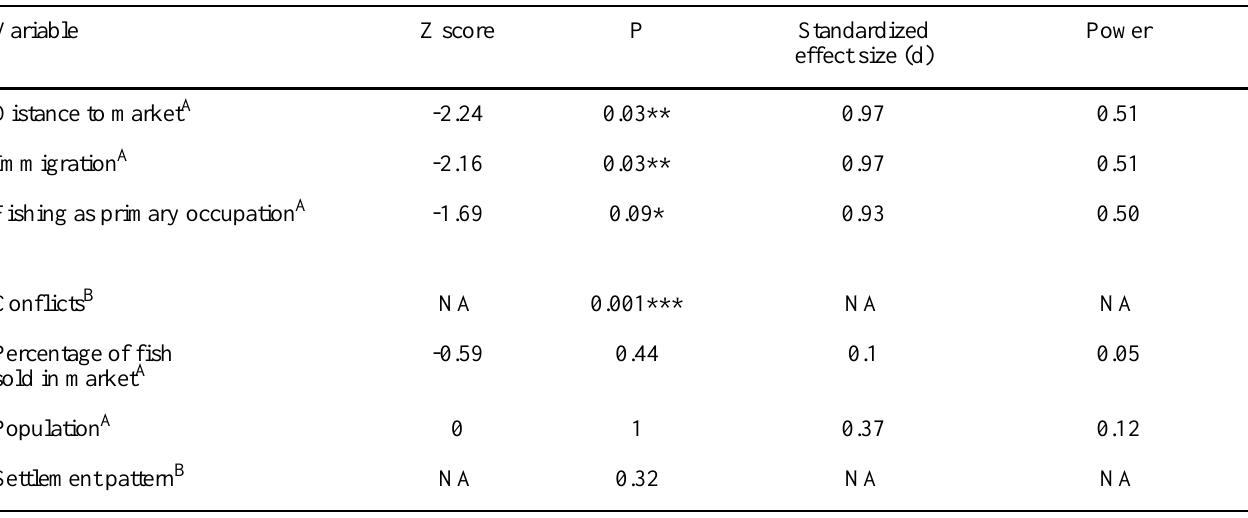
Table 2 . Differences in socioeconomic characteristics of communities with and without exclusive marine